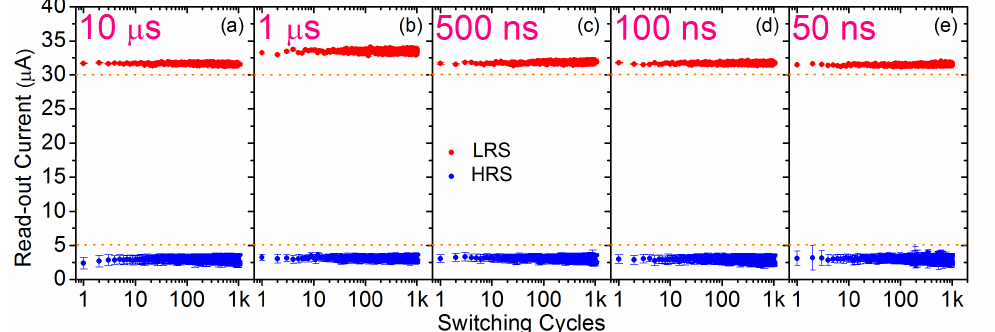
Figure 6. Mean and dispersion values of read-out currents measured just after the reset (blue) and set (red) transitions during 1k endurance cycles for every programming pulse width: 10 µ s ( a ), 1 µ s ( b ), 500 ns ( c ), 100 ns ( d ) and 50 ns ( e